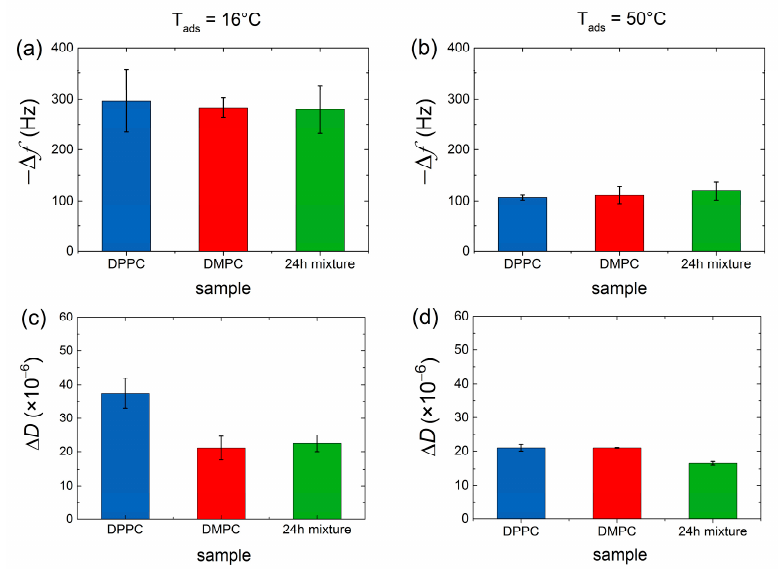
Figure 1. Frequency shifts Δ f ( a,b ) and dissipation shifts Δ D ( c,d ) for the third overtone observed during the adsorption of pure DMPC (red), pure DPPC (blue), and 24 h incubated DPPC/DMPC mixture (green) at T ads = 16 °C (a, c) and T ads = 50 °C ( b,d ) on Au-coated quartz sensors. Results obtained at T ads = 32 °C can be found in SI (Figure S1).